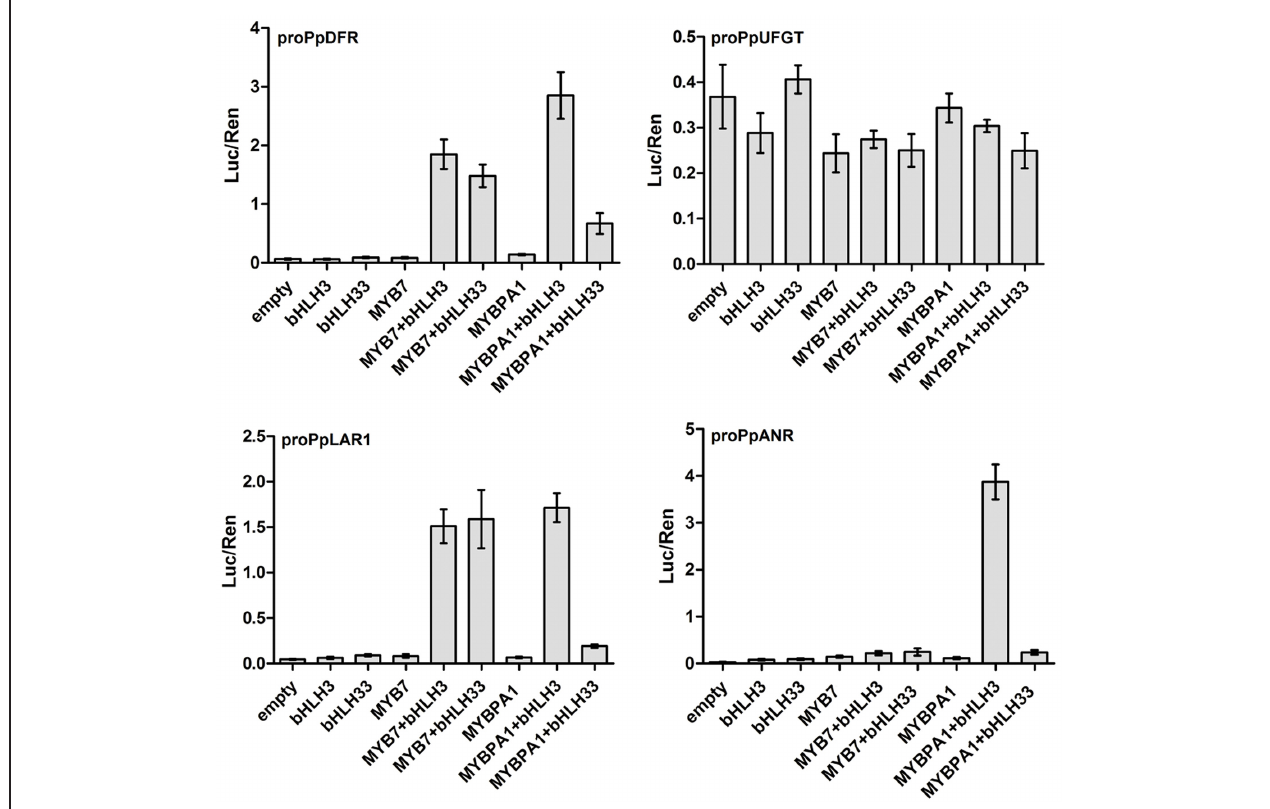
FIGURE 5 | Analysis of the interaction of PpMYB7 and PpMYBPA1 with the promoters of PpDFR , PpLDOX , PpLAR1 , and PpANR in transiently transfected Nicotiana benthamiana leaves. Luc and Ren were measured 3 days after infiltration, and error bars show SE of four biological